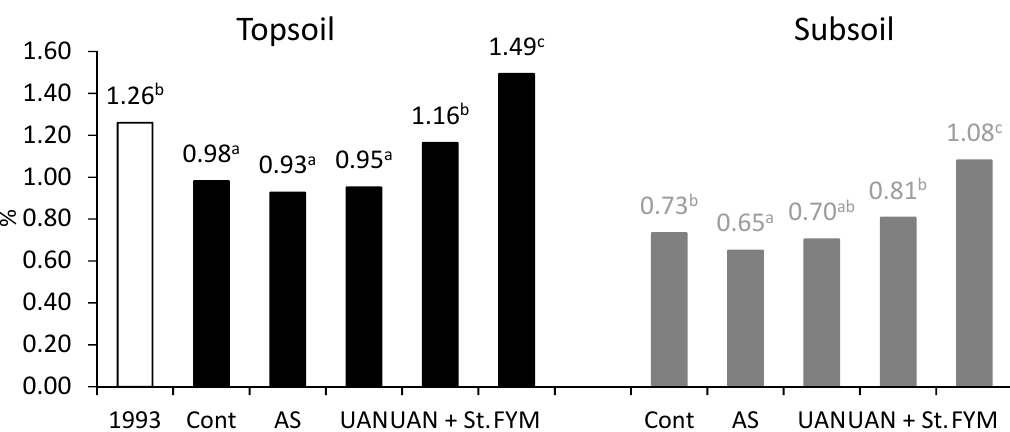
Figure 2. Soil organic matter carbon (C SOM ) content in topsoil and subsoil; different letters behind the values are meaning significant differences among investigated treatments (Tukey test; p < 0.05); number of replications per treatment n = 4.